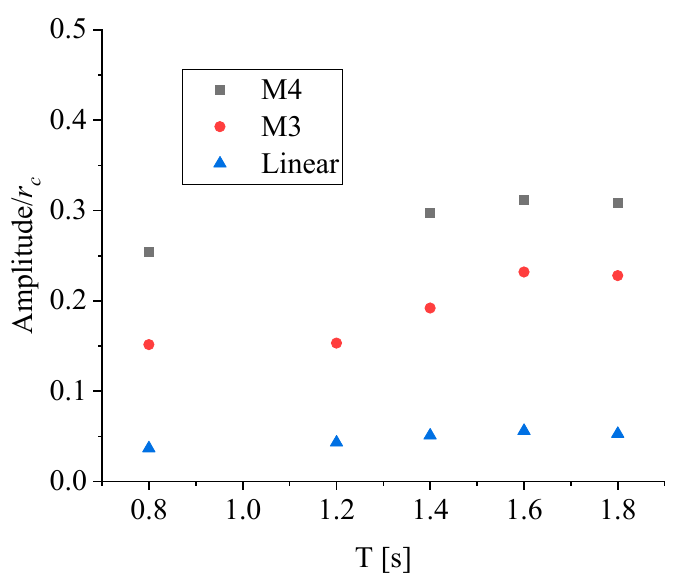
Figure 23. The amplitude of the motion for different materials versus wave period. The power output of the fWEC at full scale was calculated via a post-process proce- dure using the calculated data from the CFD-FEA results. The details of the power calcu- lation can be found in [9,41].